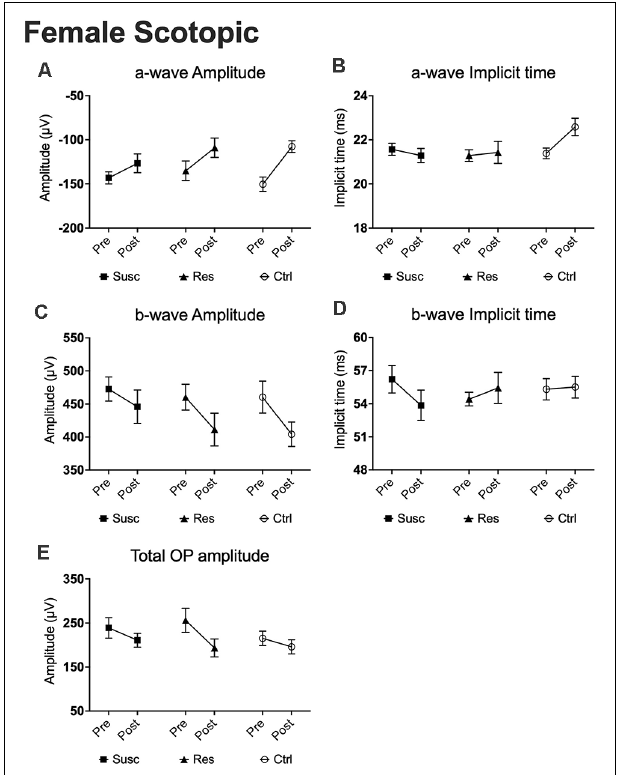
FIGURE 6 | The evolution of each ERG component under the scotopic condition at baseline and after CSDS in female mice representing the susceptible, resilient, and control a-wave amplitude (A) , a-wave implicit time (B) , b-wave amplitude (C) , b-wave implicit time (D) , and total OP amplitude (E) . Significance was determined using linear mixed model analysis with LSD multiple comparisons test. Symbols and bars represent the group average ± SEM; n -values are given in the “Materials and Methods” section.